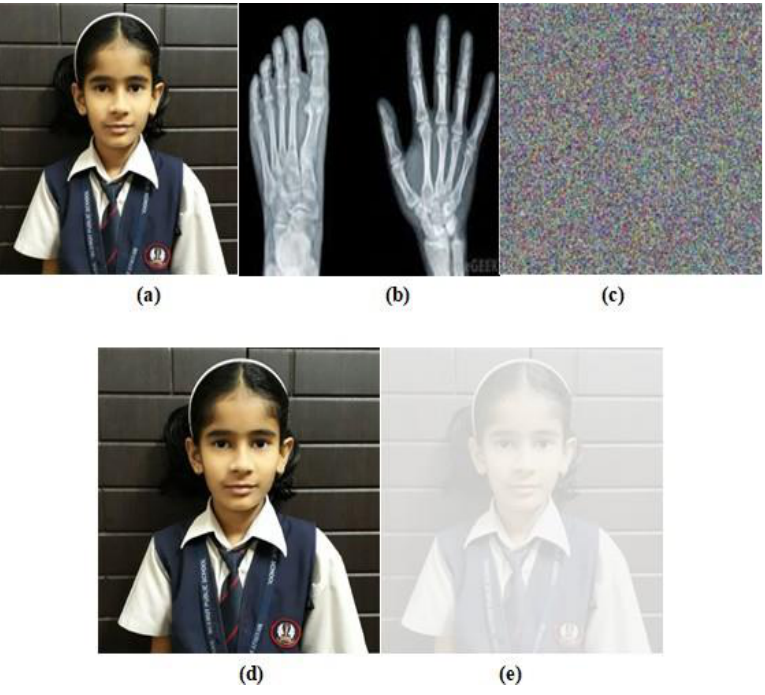
Figure 7. Visual analysis: ( a ) Sanchi spread image, 512×512, ( b ) watermarked image, 256×256, ( c ) chaotic calculated planned watermarked image, ( d ) Sanchi watermarked image, ( e ) RSA-encrypted image. To test the robustness with standard grayscale medical images, palm X-ray, brain tumor, ultrasound, and chest X-ray images of size 256 × 256 are considered as the experi- mental images, as shown in Figure 8.